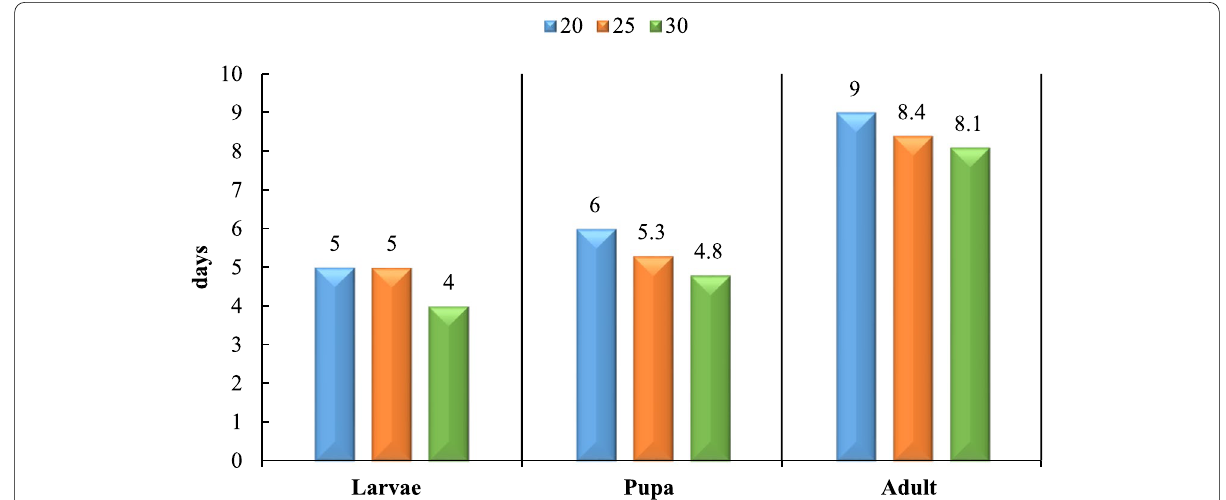
Fig. 2 Developmental duration (days) of Chrysomya albiceps for each stage at different constant temperatures ( n